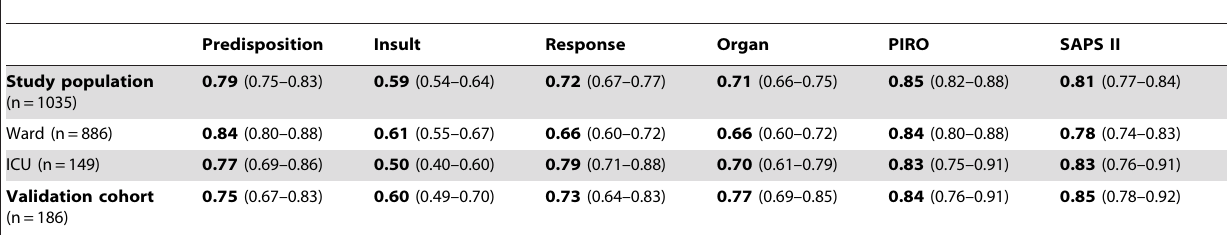
Table 4. Area under the receiver operating characteristics curve (95% Confidence Interval) of predicted probabilities by hospital mortality of each PIRO component, the combined PIRO model and SAPS II, in the derivation and in the validation